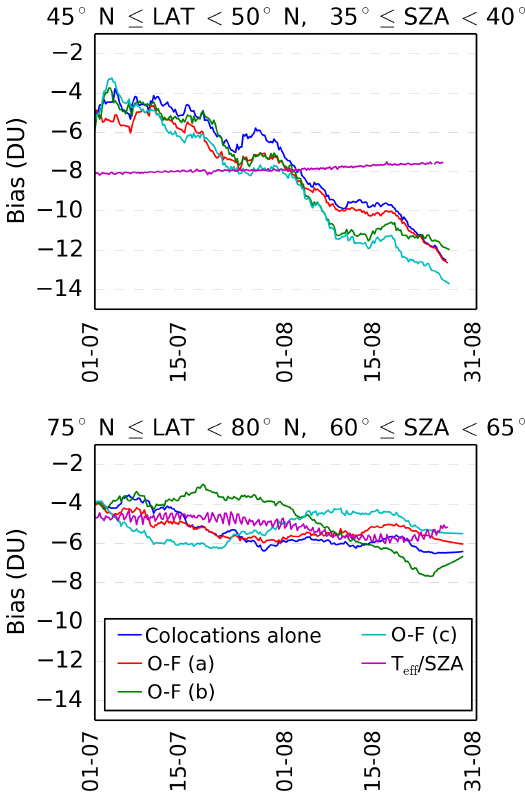
Figure 6. Time series of total column ozone bias corrections (DU) for two latitude/SZA bins covering July–August 2014 for GOME-2A using different bias-correction methods. All cases that include colocation methods use thinned observation sets. The “ O - F ” curves additionally use the differences of forecasts described in Sect. 4.2 following the assimilation of OMI-TOMS. The “colo- cations alone” and “ O - F ” curves were calculated using the Gaus- sian 2-week moving average with a half width at half maximum of 4.7d. The “ T eff / SZA” curves, described in Sect. 4.3, result from mapping each observation that falls within the latitude/SZA bin onto the ozone effective temperature/SZA bias estimate for July– August 2014 (shown in Fig. 7), followed by taking the average of these bias estimate values for each